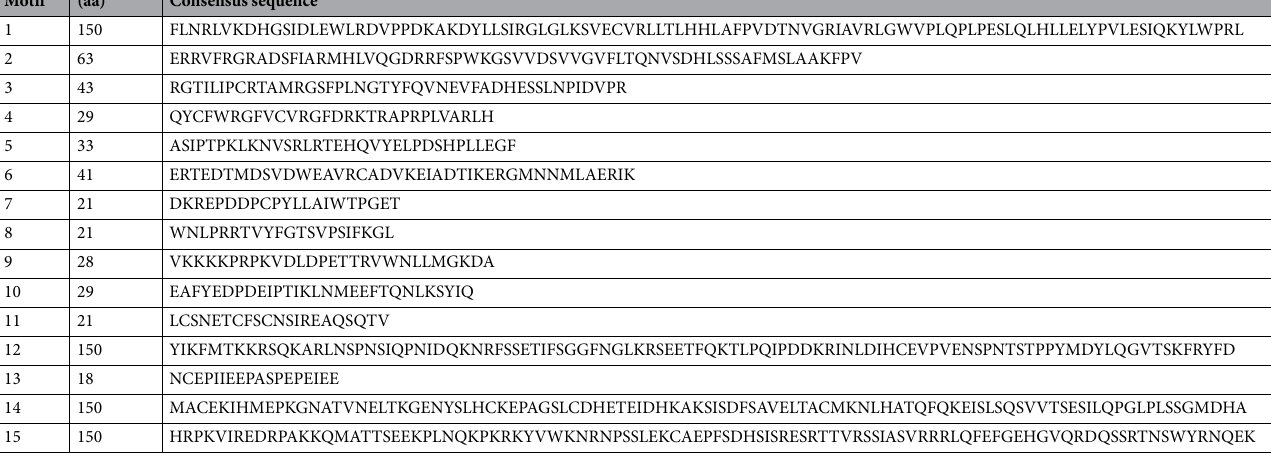
Table 2. Consensus sequences of 15 motifs identified in SmDMLs, AtDMLs and OsDMLs.